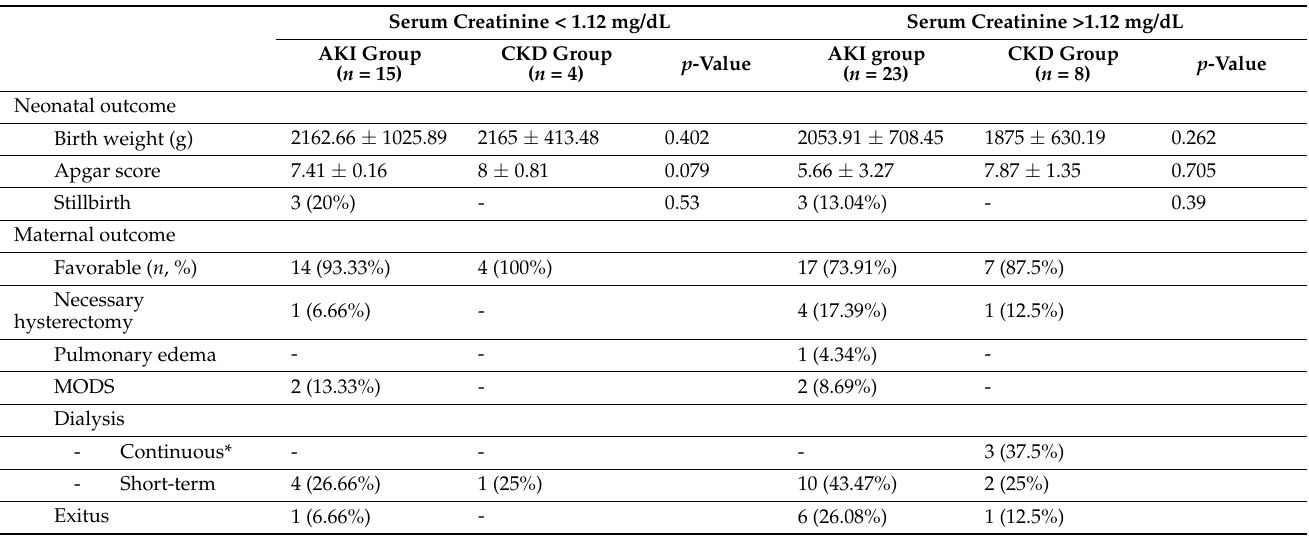
Table 5. Neonatal and maternal characteristics by a threshold value of serum creatinine. Serum Creatinine < 1.12 mg/dL